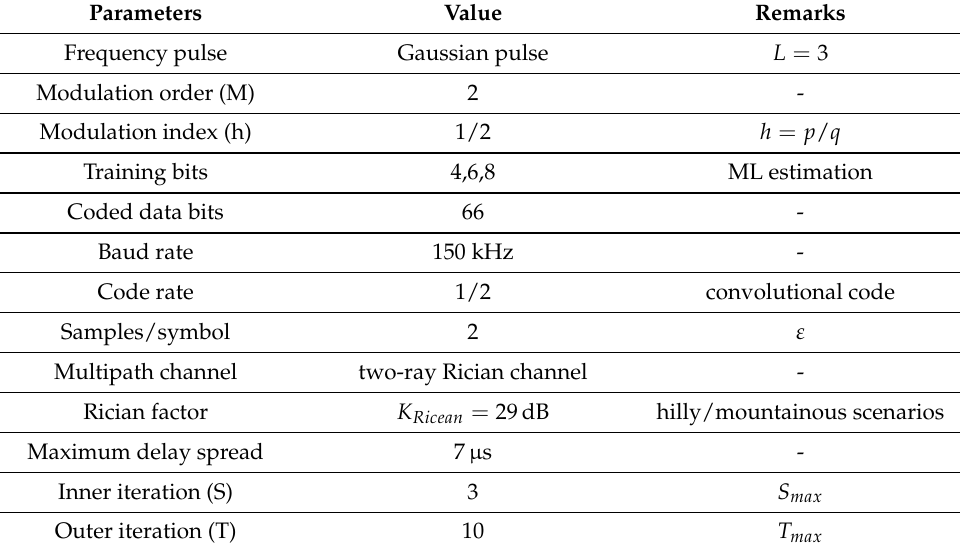
Table 3. Simulation